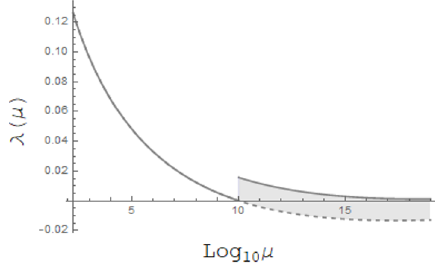
Figure 3 . An example of the scalar threshold e(cid:11)ect, in which m ’ = 10 10 GeV, (cid:21) (cid:30) = 10 (cid:0) 6 , and (cid:20) = 2 : 5 (cid:2) 10 (cid:0) 4 . In this case, Higgs vacuum stability is restored up to the Planck scale with the apparent discontinuity at the m ’ mass scale, near the instability scale, being due to the scalar threshold e(cid:11)ect. In the numerical calculations the 2-loop RGEs for the SM couplings are used, and are given in appendix B [64], with initial input values the central experimental values given in